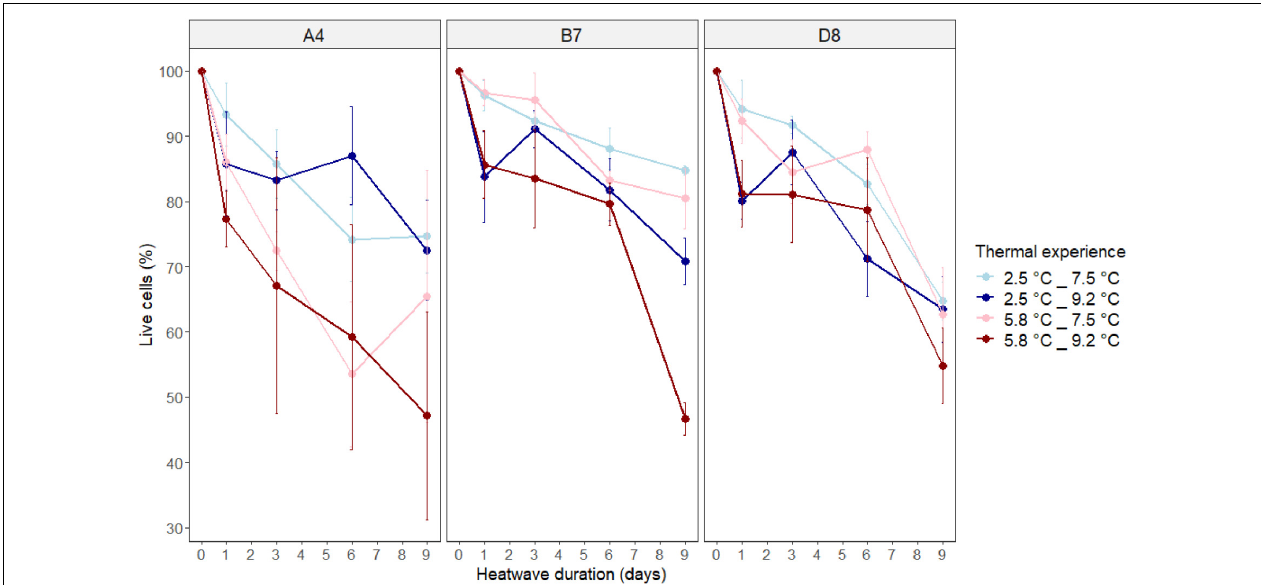
FIGURE 2 | Mortality of experimental populations during simulated heatwaves, shown as the percentage of live cells in experimental populations relative to the percentage of live cells on day 0. Thermal experience is defined by the combination of acclimation temperature (2.5 or 5.8 ◦ C) and heatwave temperature (7.5 or 9.2 ◦ C). Panels show the results for each genotype (A4, B7, and D8) of A. actinochilus . Data points represent average values for three independent replicates ± one standard deviation.